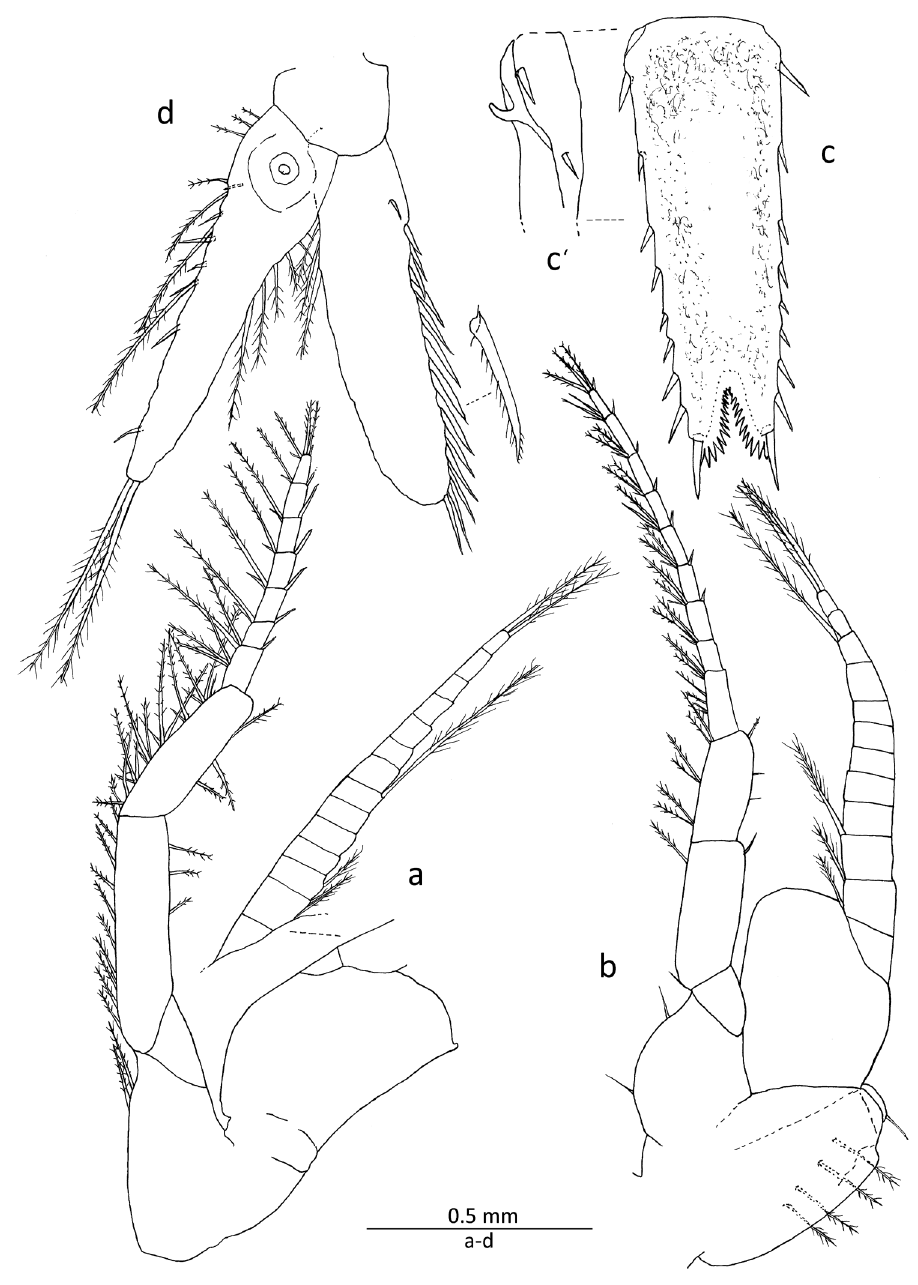
Figure 4. Gastrosaccus lombokiensis sp. n., paratype male (TL ca. 7.5 mm): a right sixth thoracic limb, posterior view b left eighth thoracic limb and penis, anterior view c telson, dorsal view c’ basal part of telson, lateral view d right uropod, dorsal